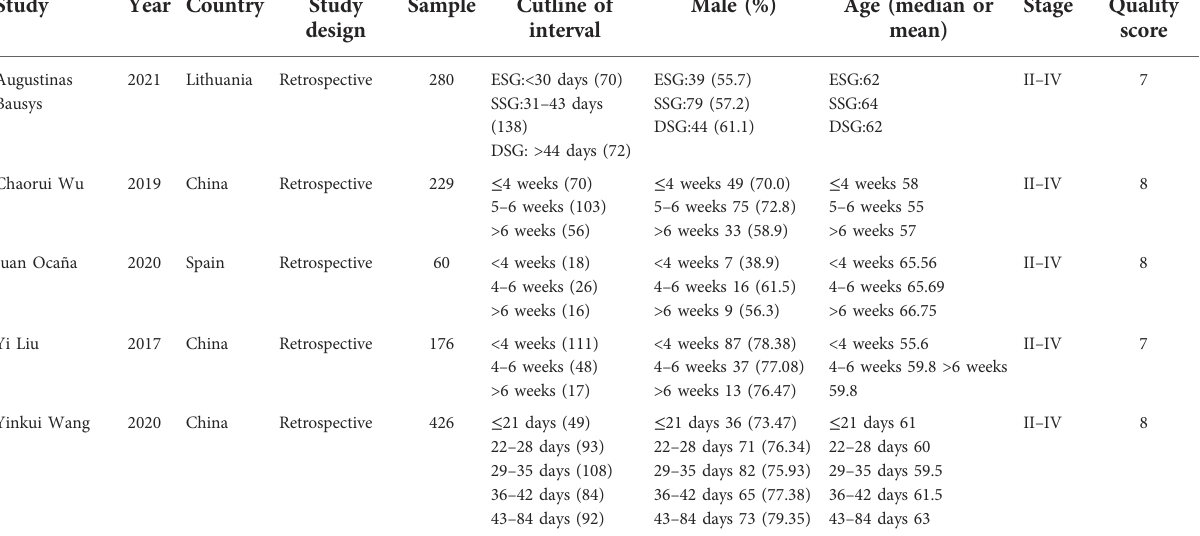
TABLE 1 Characteristics of the included